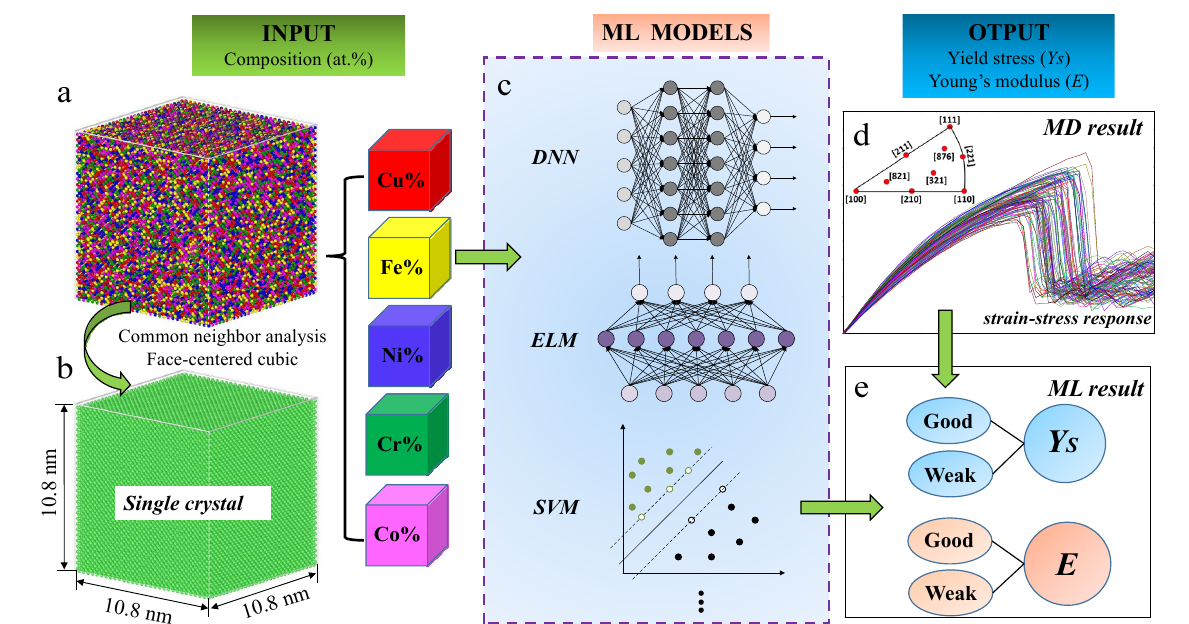
Figure 1. Schematic diagram of MD simulation and ML methods. ( a ) Atomic configuration of a CuFeNiCrCo single-crystal sample, atoms are coloured according to the element types. ( b ) Atoms are coloured by the common neighbour analysis (CNA) method. The green atoms denote the face-centered cubic structure. ( c ) Schematic of the working principles of some ML models, including deep neural network (DNN), extreme learning machine (ELM), and support vector machine (SVM). ( d ) Strain-stress response of single-crystal HEA samples with various element compositions along [110] orientation by MD simulation. The inverse pole figure indicates nine different crystallographic orientations tested in this study. ( e ) Prediction of the mechanical properties (Ys and E) by ML method.